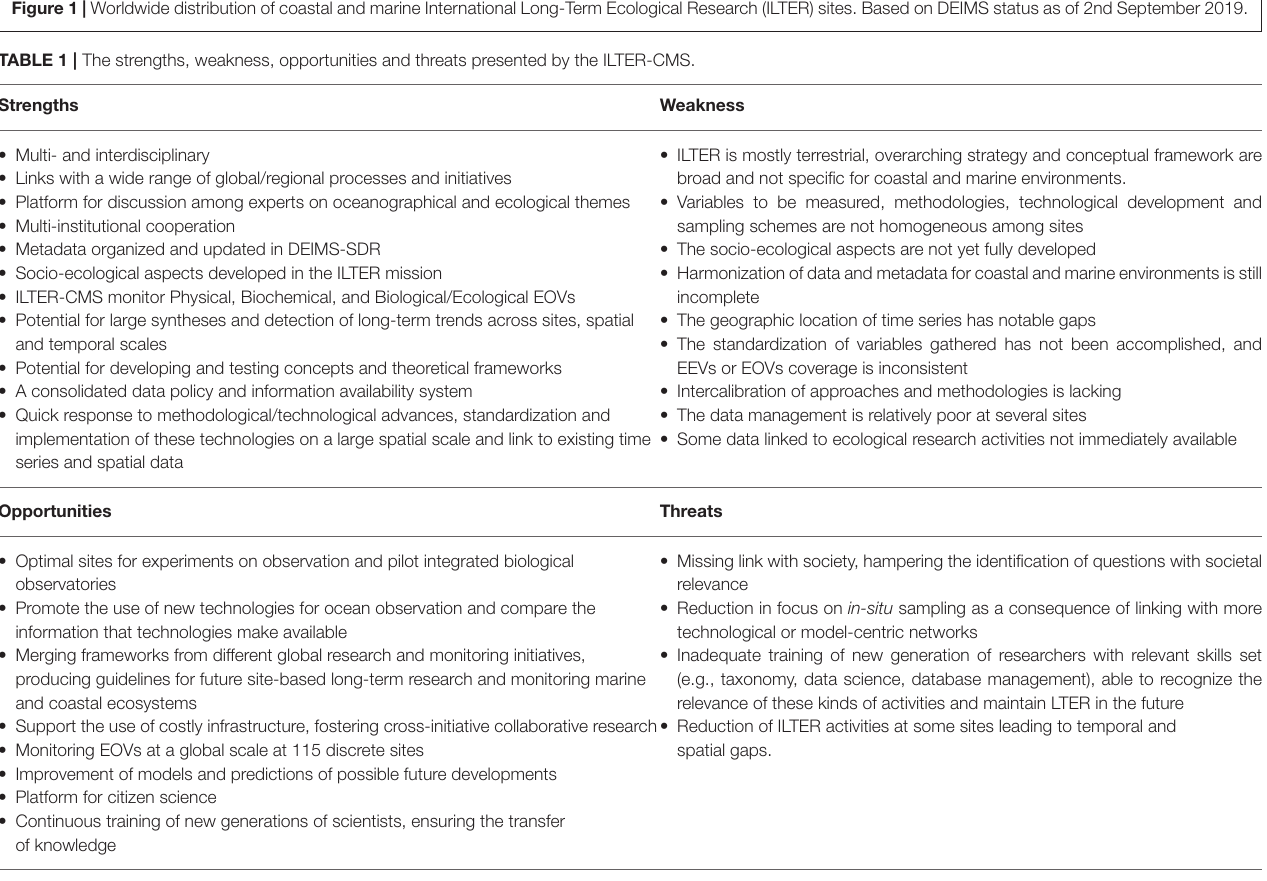
“ Table S1 . ILTER-CMS site name, location, year of establishment and habitat type. Site name,